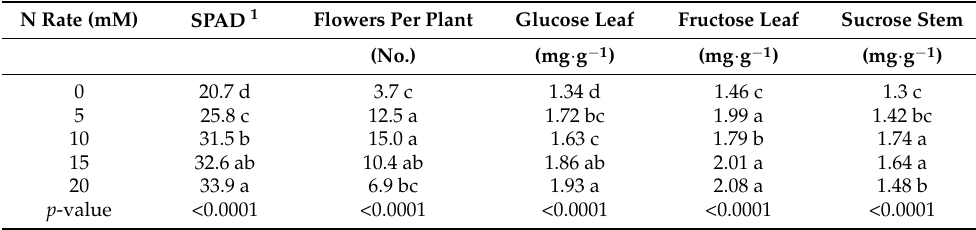
Table 2. Leaf SPAD, flower count, and carbohydrate concentrations in Encore ® azalea ‘Chiffon’ affected by N fertigation rate.